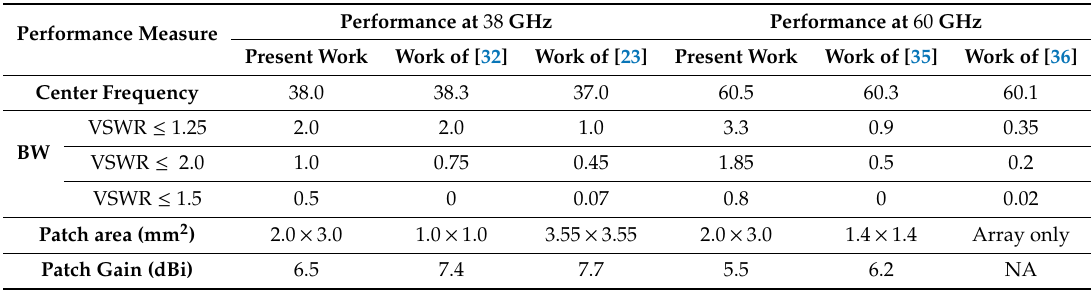
Table 3. Comparison between the bandwidth achieved in the present work to that achieved in other published